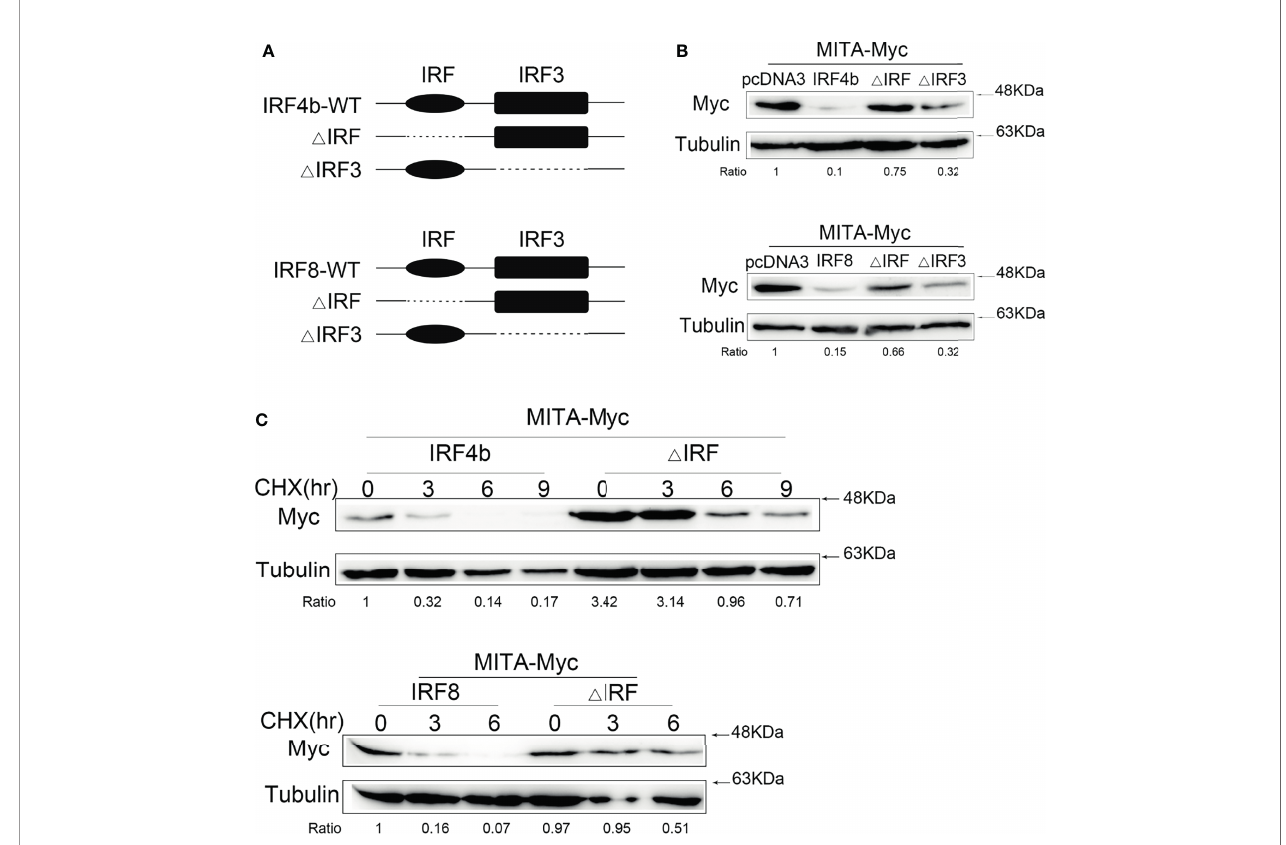
FIGURE 5 | IRF is the core domain of IRF4b and IRF8 in the regulation of MITA. (A) Schematic diagrams of the wild type (WT) and mutants of IRF4b or IRF8. (B) IRF4b and the mutants of IRF4b were transfected with MITA into EPC cells, and the dose of each plasmid was 0.4 m g (above). MITA was checked by immunoblot assays after 24 h posttransfection, and similar experiments were performed with IRF8, the mutants of IRF8 and MITA (below). (C) The IRF-related mutant of IRF4b or IRF8 and IRF4b or IRF8 was transfected with MITA into EPC cells, and CHX was added at 24 h posttransfection. The cells were lysed at different time points and immunoblot assays were conducted. All the experiments were performed independently at least three